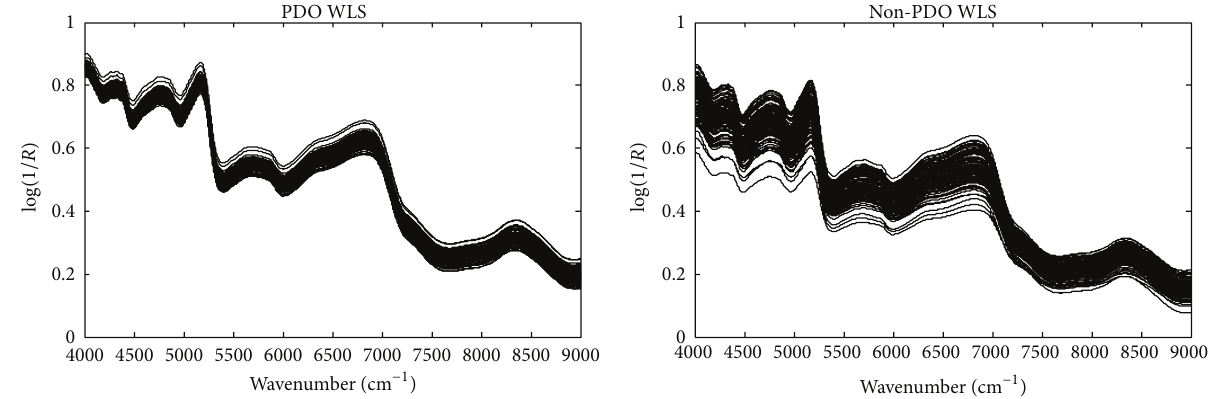
Figure 2: The raw NIR spectra of PDO and non-PDO WLS objects.